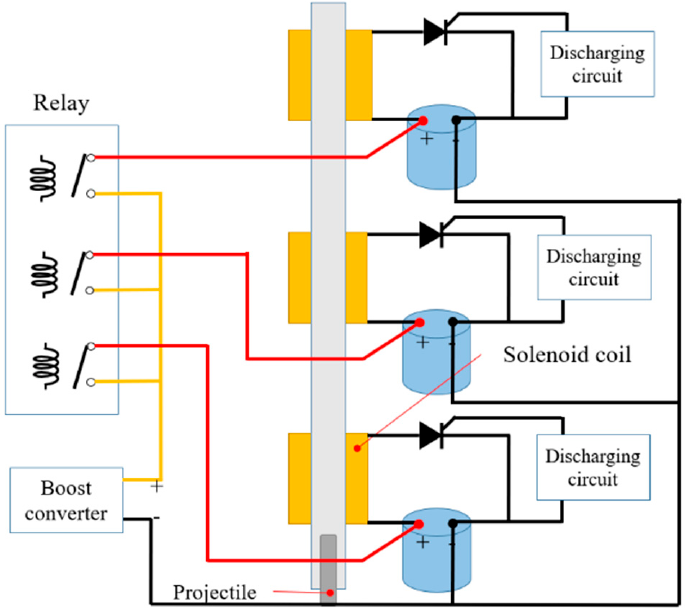
Figure 7. A schematic diagram of the multi − stage coil gun charging circuit.